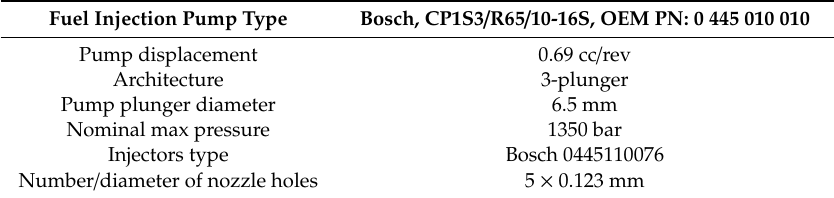
Table 4. PSA DW10 ATED injection system specifications.